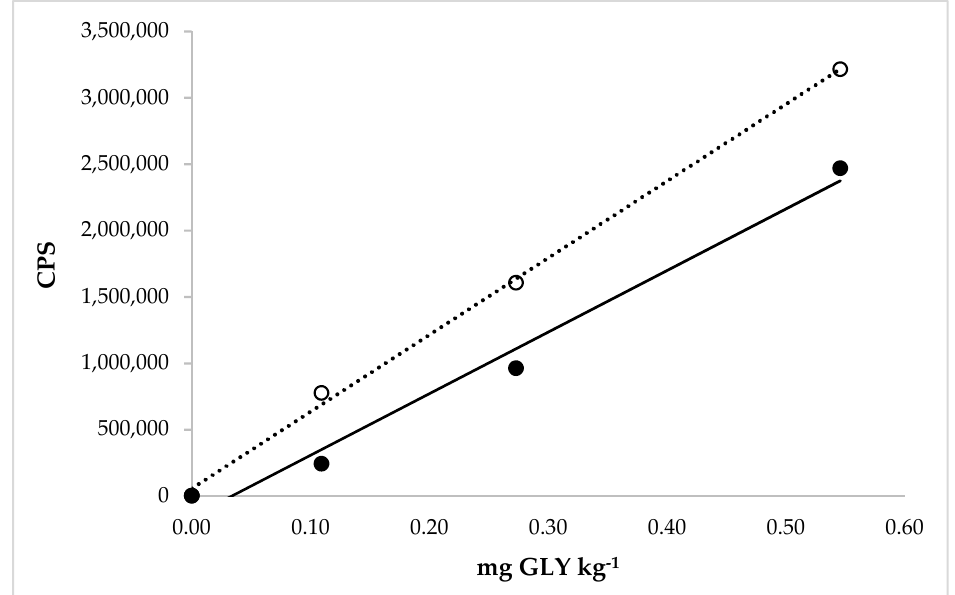
Figure 5. Comparison between the calibration curves of GLY in the extraction solution (dotted line) with linear equation y = 5.789 × 10 6 x + 57,500 and regression fit 0.998 and in the extraction solution with the matrix (brown rice, solid line) with linear equation y = 4.636 × 10 6 x − 155,600 and regression fit 0.982.